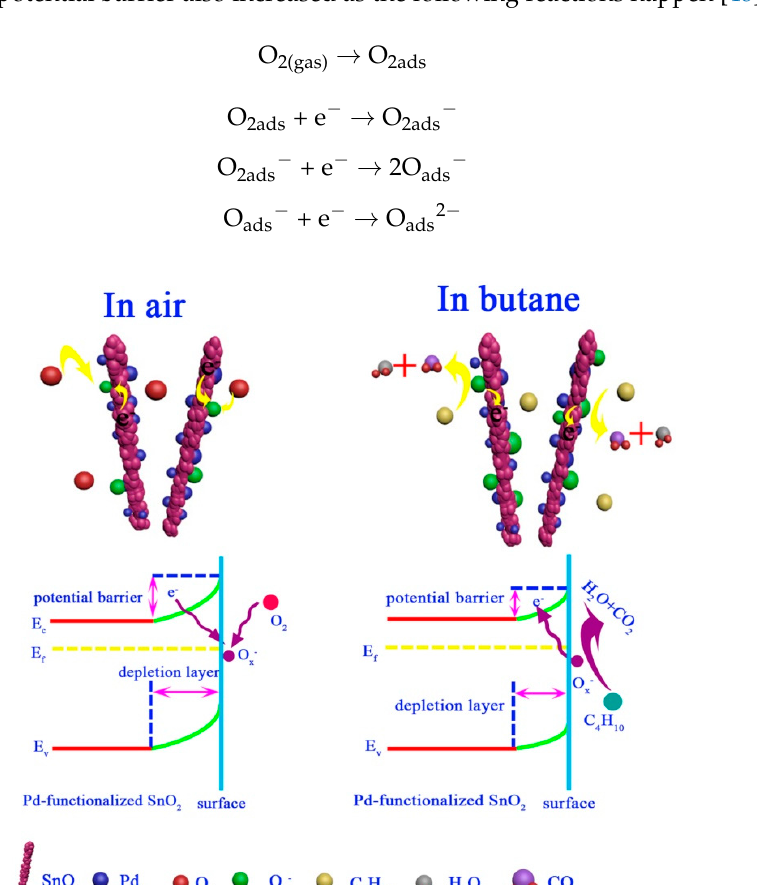
Figure 8. Schematic illustration of the gas-sensing mechanism toward butane and the energy band structure of the sensor based on 5 mol % Pd-functionalized SnO 2 nanofibers in air and